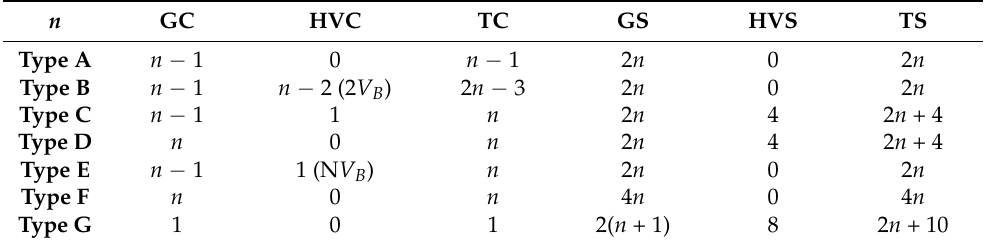
Table 1. Comparison of the number of components and their requirements for each SC-based BE.